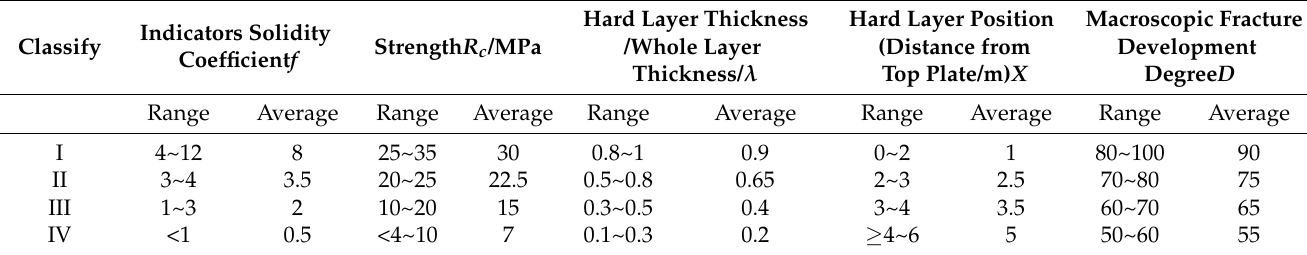
Table 2. Fuzzy classification factor index of stability of large mining height coal walls.